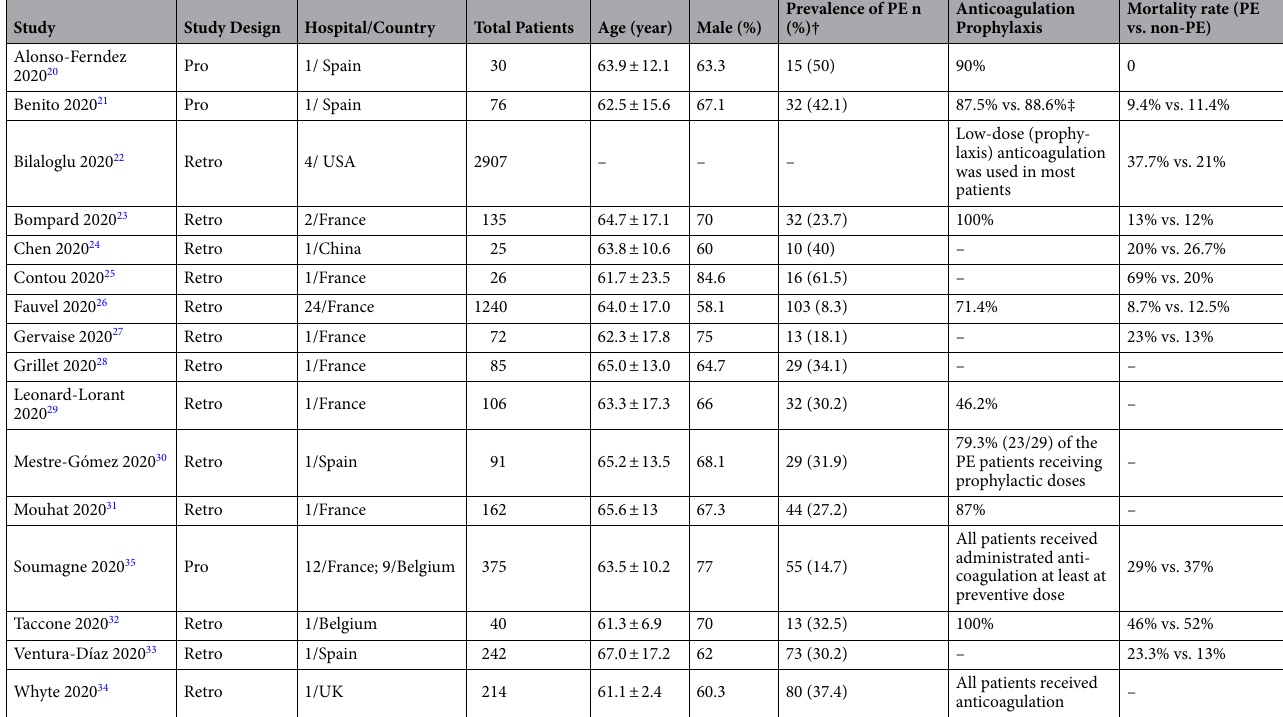
Table 1. Characteristics of the included studies (n = 16). Pro, prospective; Retro, retrospective; †Prevalence of PE in patients receiving computed tomography pulmonary angiography; USA, United States; UK, United Kingdom.